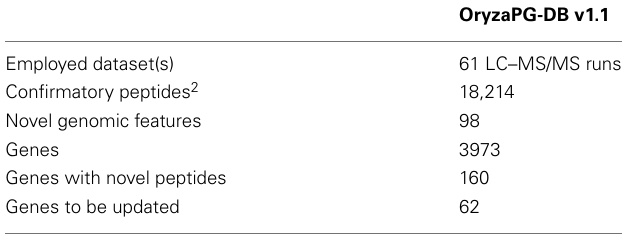
Table 2 | OryzaPG-DB current status 1 .